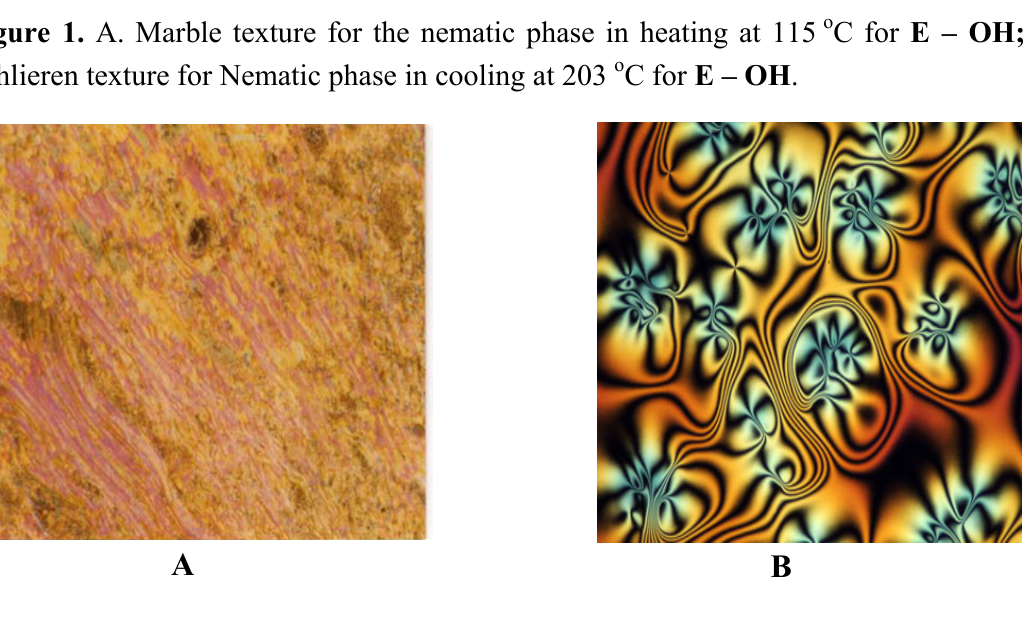
Figure 2. A. Schlieren texture for S phase in heating at 189 o C for E –H; B. Broken Fan C Shaped texture for S phase in cooling at 209 o C for E –H C